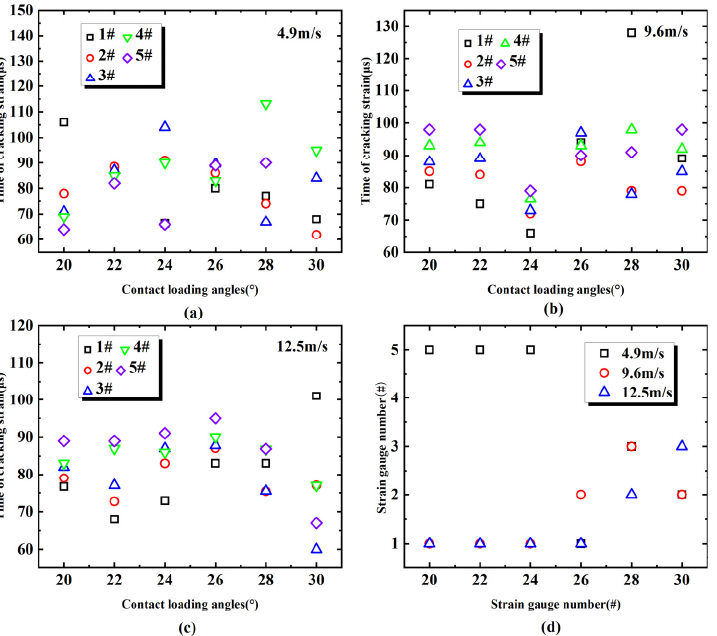
Figure 16. (a) Crack extension time sequence at 4.9m/s; (b) Crack extension time sequence at Figure 16. ( a ) Crack extension time sequence at 4.9 m/s; ( b ) Crack extension time sequence at 9.6 m/s; 9.6m/s; (c) Crack extension time sequence at 12.5m/s; (d) Start cracking point sequence; ( c ) Crack extension time sequence at 12.5 m/s; ( d ) Start cracking point